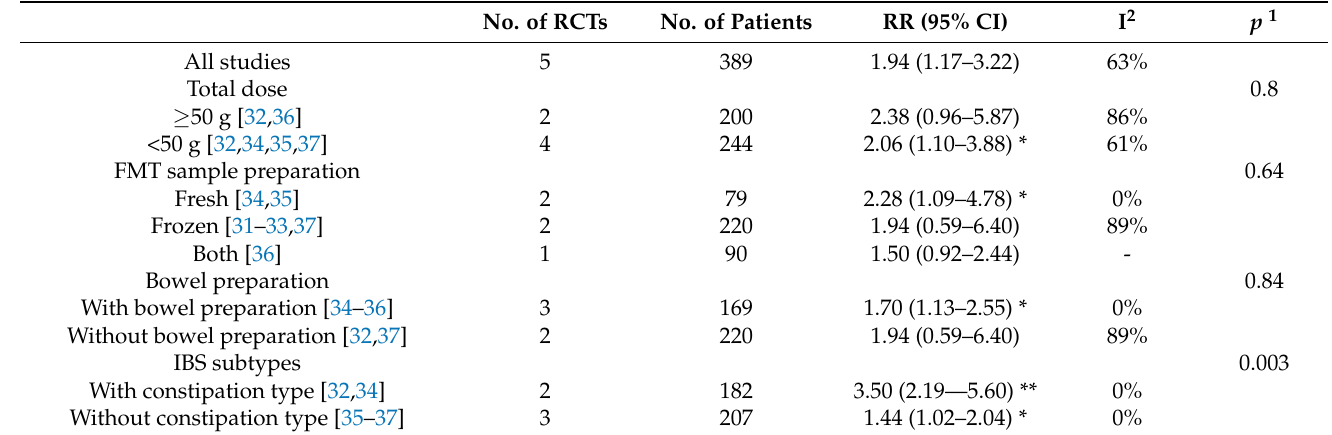
Table 5. Subgroup analyses of comparisons of FMT vs placebo in IBS between studies that delivered FMT through colonoscopy, gastroscopy and nasojejunal tube. No. of